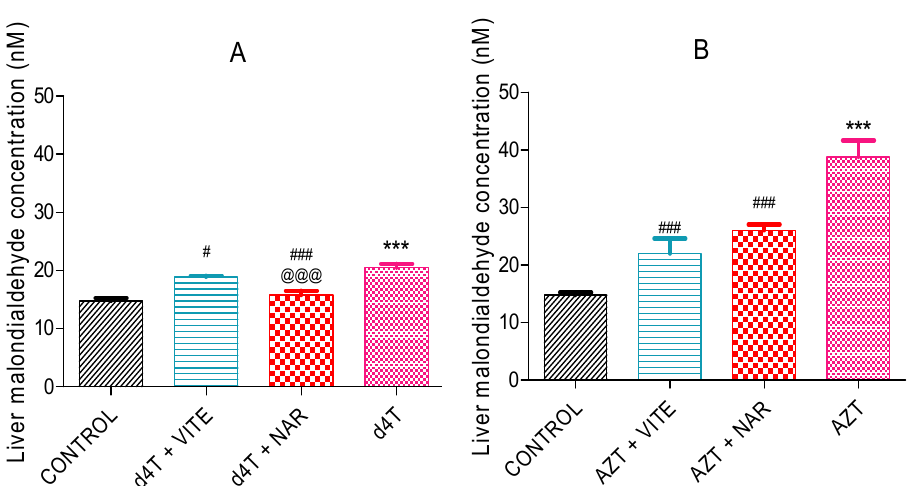
Figure 5. Liver MDA concentrations in: ( A ) d4T ‐ (*** p < 0.001 compared to control and # p < 0.05; ### p < 0.001 compared to d4T and ( B ) AZT ‐ (*** p < 0.001 compared to control; ### p < 0.001 compared to AZT) treated animals after 56 days of drug administration. @@@ p < 0.001 compared to vitamin E among d4T ‐ treated rats.